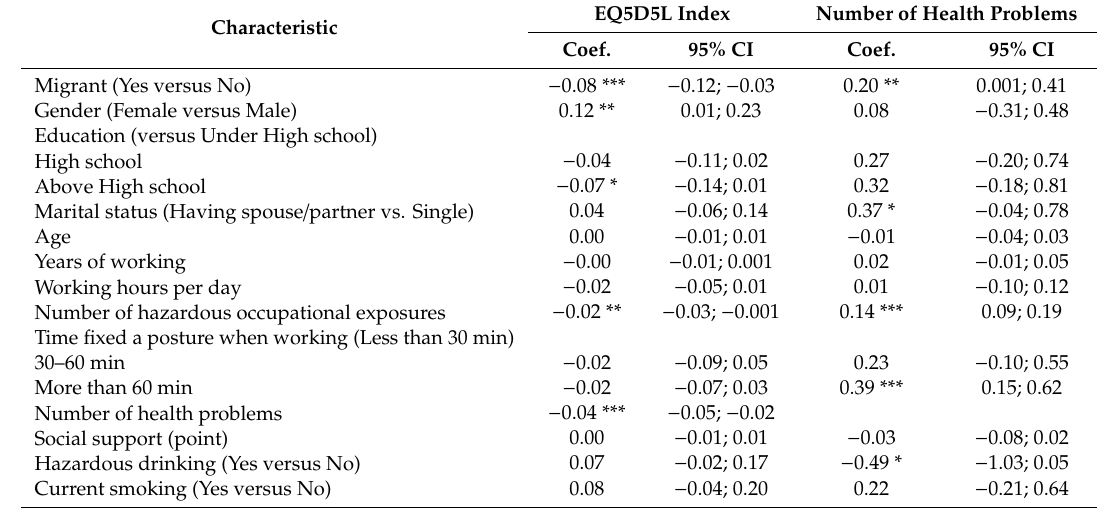
Table 4. Associated factors with health-related quality of life (HRQOL) and number of health problems. EQ5D5L Index Number of Health Characteristic